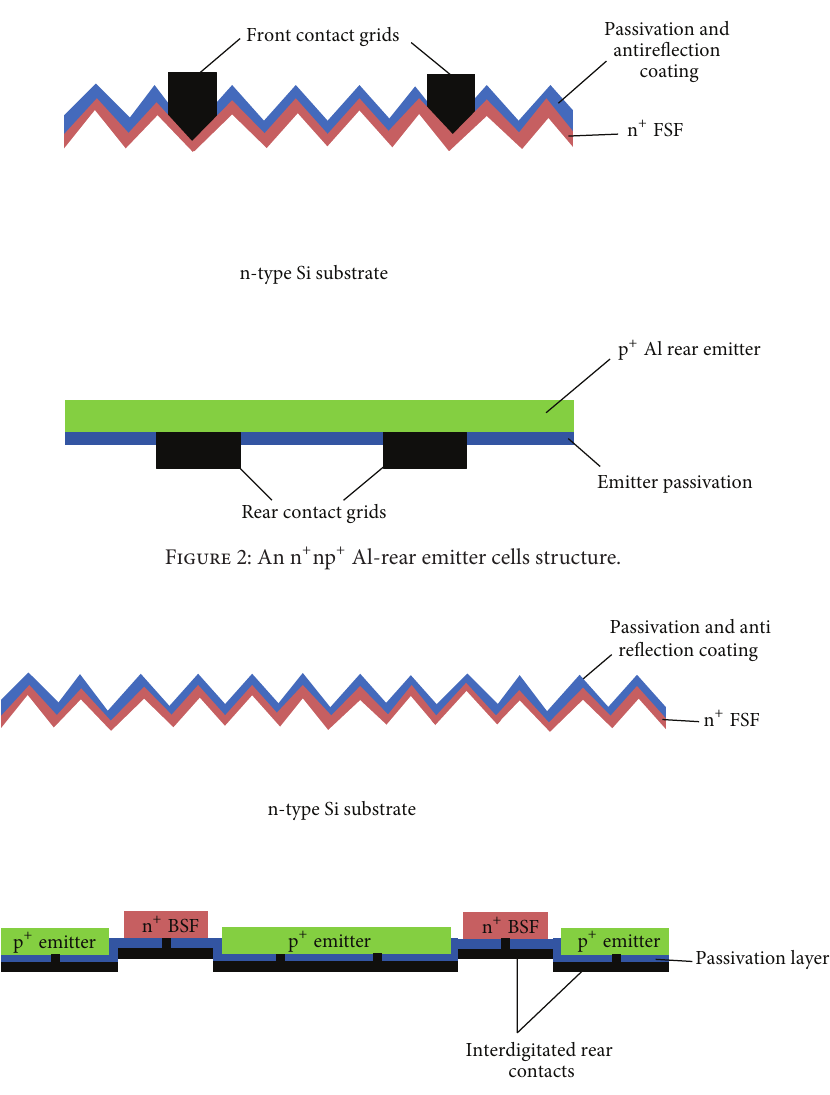
Figure 3: Schematic of back-junction back-contact n-type base c-Si solar cell. The rear contact is designed as an interdigitated back contact such as IBC cell from SunPower. This cross-section of IBC cell developed at ISFH shows an open front side n + -FSF, passivated and coated with antireflection coating